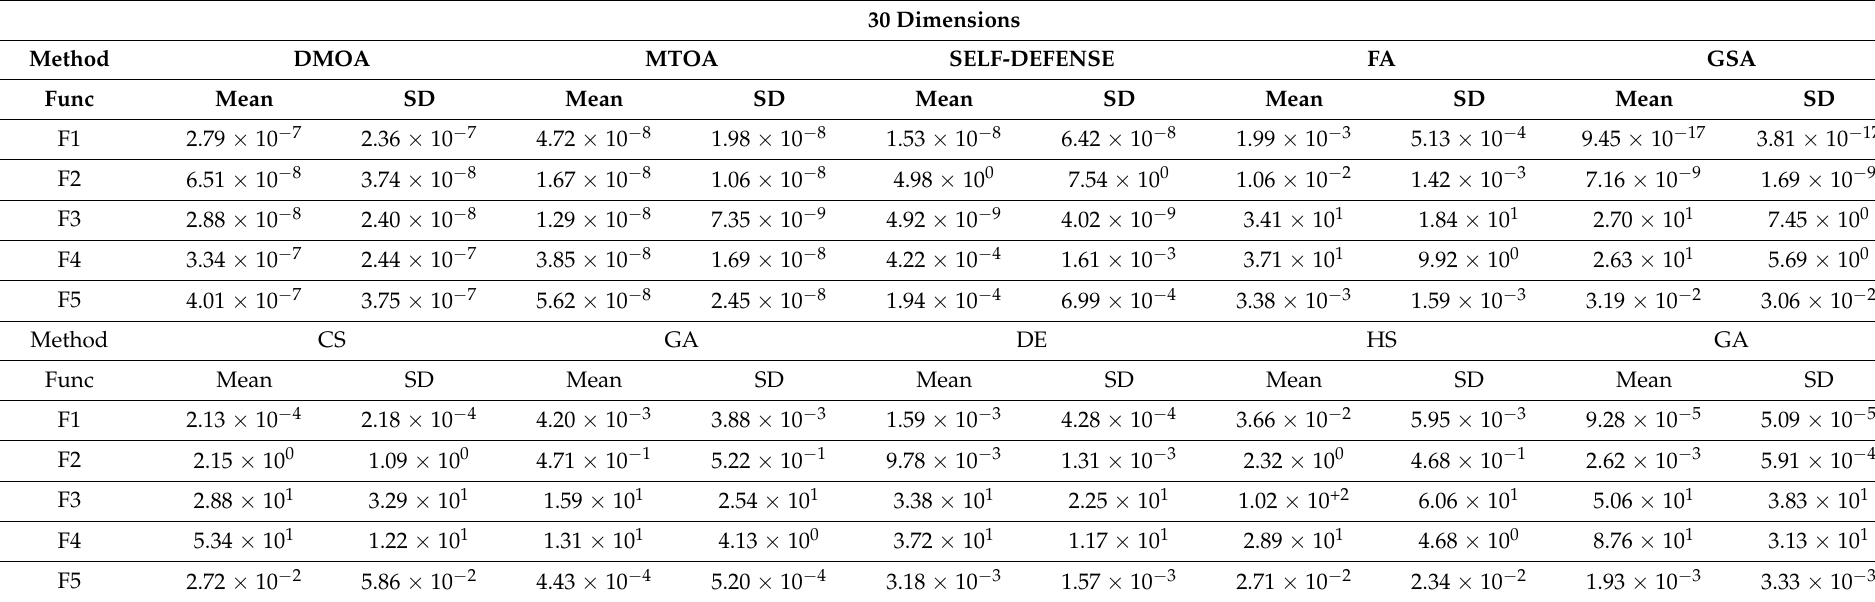
Table 13. Comparison of the Mean and Standard Deviation of the DMOA Algorithm with other methods, for 30 dimensions. 30